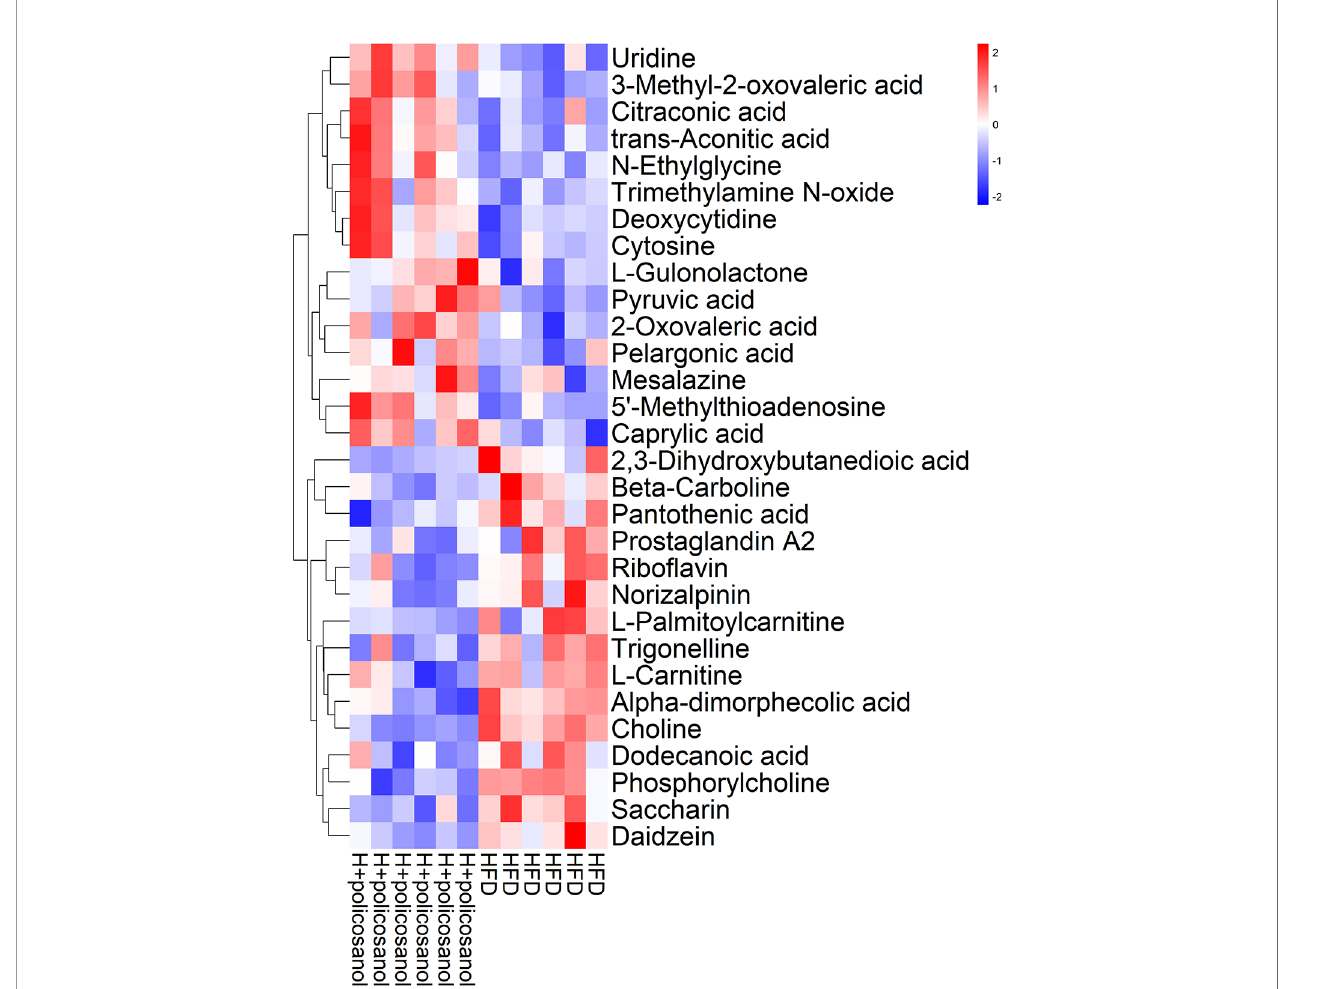
FIGURE 6 | Hierarchical clustering analysis of top the 30 metabolites in mice. Heat map of top the 30 metabolites in HFD and HFD +policosanol groups. The red and blue indicate upregulation and downregulation,